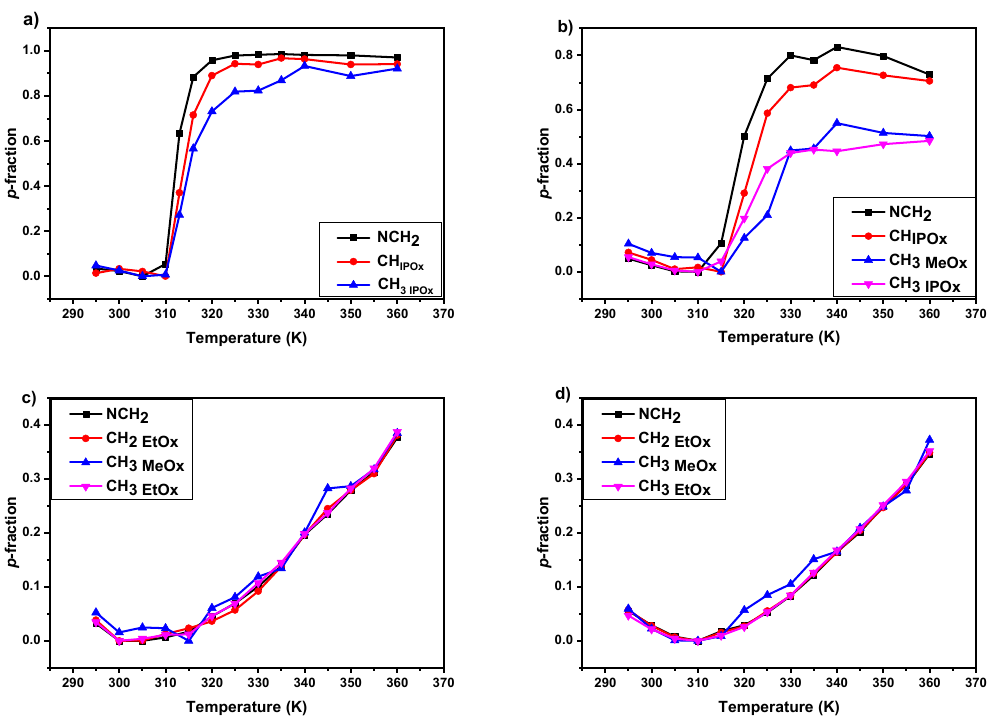
Figure 4. Temperature dependences of the fraction p as determined for all signals of various proton types in D 2 O solutions ( c = 5 wt%) of PIPOx homopolymer ( a ) and P(MeOx / IPOx)(14 / 86) ( b ), P(MeOx / EtOx)(28 / 72) ( c ), P(MeOx / EtOx)(7 / 93) ( d ) copolymers during gradual heating. Temperature dependences of the fraction p of D 2 O solutions ( c = 5 wt %) of all investigated